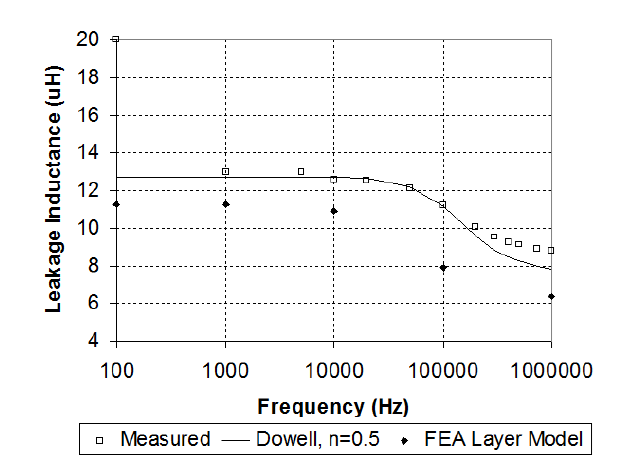
Figure 6: Layer by Layer 2D Finite Element Model